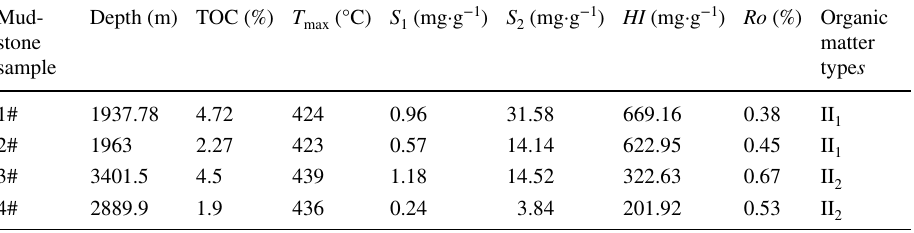
characteristics of the four samples (from Ma et al., 2013)